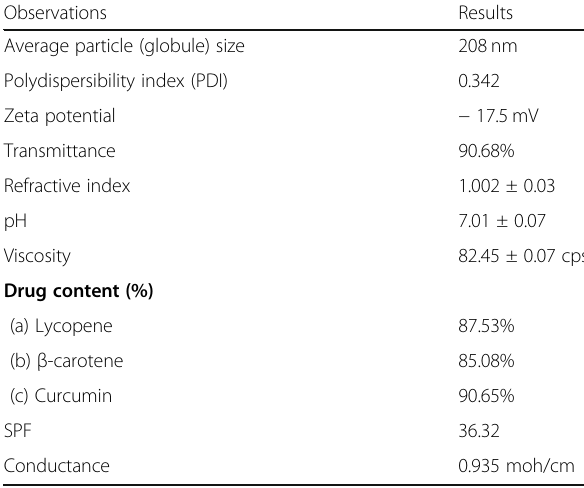
Table 2 Various evaluation parameters of an